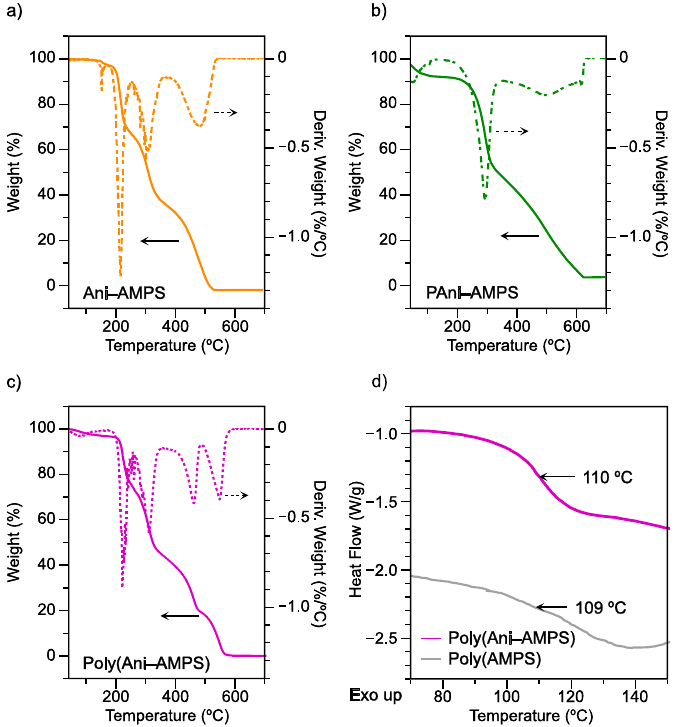
Figure 9. TGA traces and weight derivative of ( a ) Ani-AMPS, ( b ) PAni-AMPS, ( c ) Poly(Ani-AMPS), and ( d ) glass transition temperatures (T g ) of Poly(Ani-AMPS) and Poly(AMPS-acid).